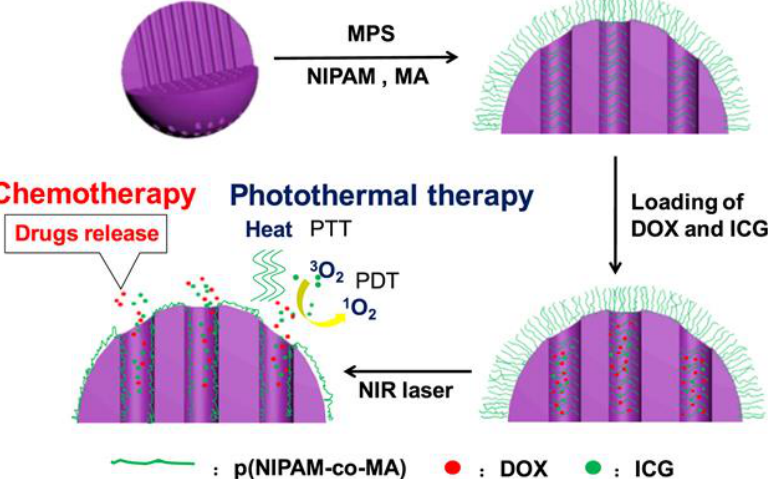
Figure 4. Loading and release of DOX and ICG from MSNs coated with PNIPAM copolymerized with methacrylic acid. The copolymer is abbreviated as p(NIPAM-co-MA). Copolymers are grafted from the surface of the MSN, generating dense brushes across the surface and into the porous interior. While the polymers are hydrated, off-target release is restricted. Upon heating by an externally applied NIR laser, the polymers collapse and release the loaded drug. Reprinted with permission from [143] , Elsevier, 2018.